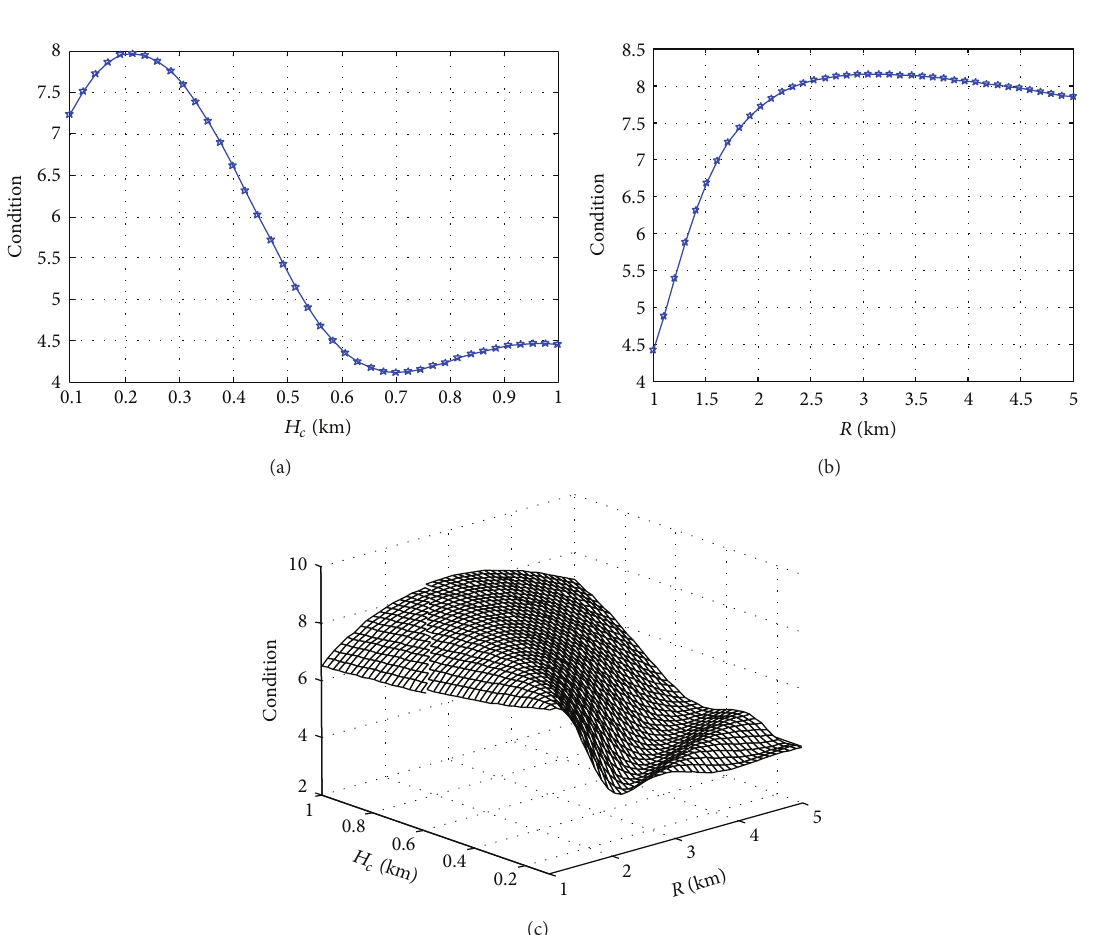
Figure 7: Influence of flight distance on the average channel capacity.